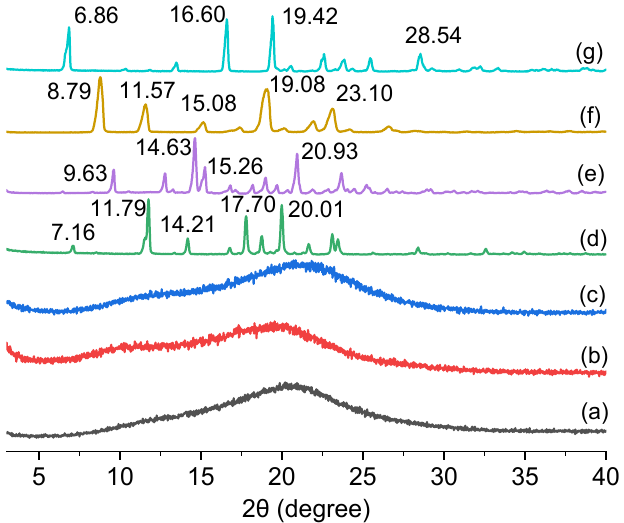
Figure 1. The PXRD patterns of co-amorphous forms of MAR-RES (a), OMAR-RES (b), and SPD-RES (c), as well as crystalline forms of matrine (d), oxymatrine (e), sophoridine (f), and resveratrol (g).